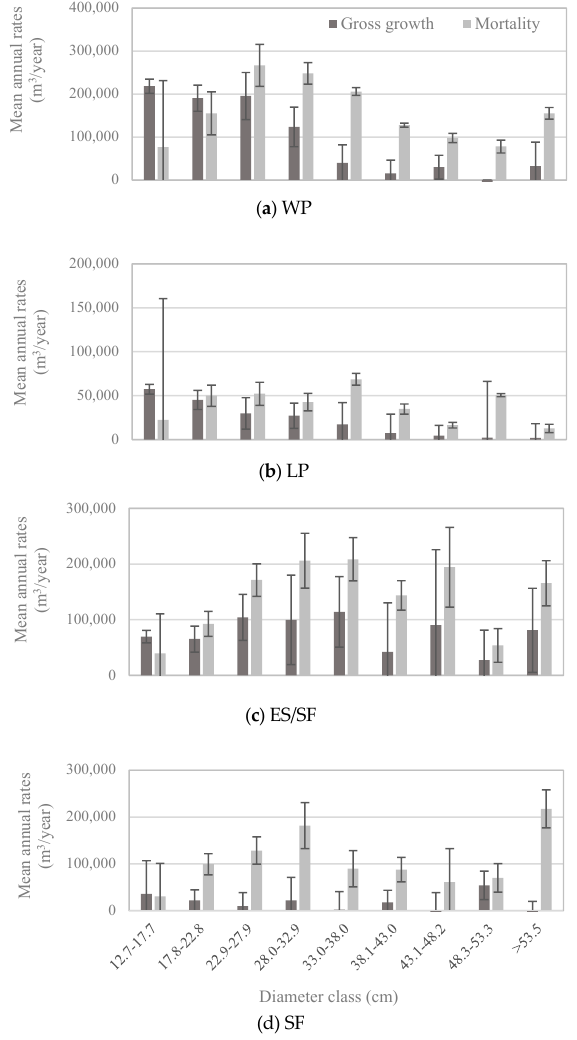
Figure 6. Mean annual volume of gross growth (dark bars) and mortality (light bars) of whitebark pine trees by diameter class, based on trees measured between 2005 and 2015 ( n = 341 plots; measurement years vary by state) within ( a ) the whitebark pine forest type (WP; n = 107 plots), ( b ) the lodgepole pine forest type (LP; n = 87 plots), ( c ) the Engelmann spruce/subalpine fir forest type (ES/SF; n = 77 plots), and ( d ) the subalpine fir forest type (SF; n = 70 plots). Note different scales of y-axes. Error bars represent +/ − one standard error [20].